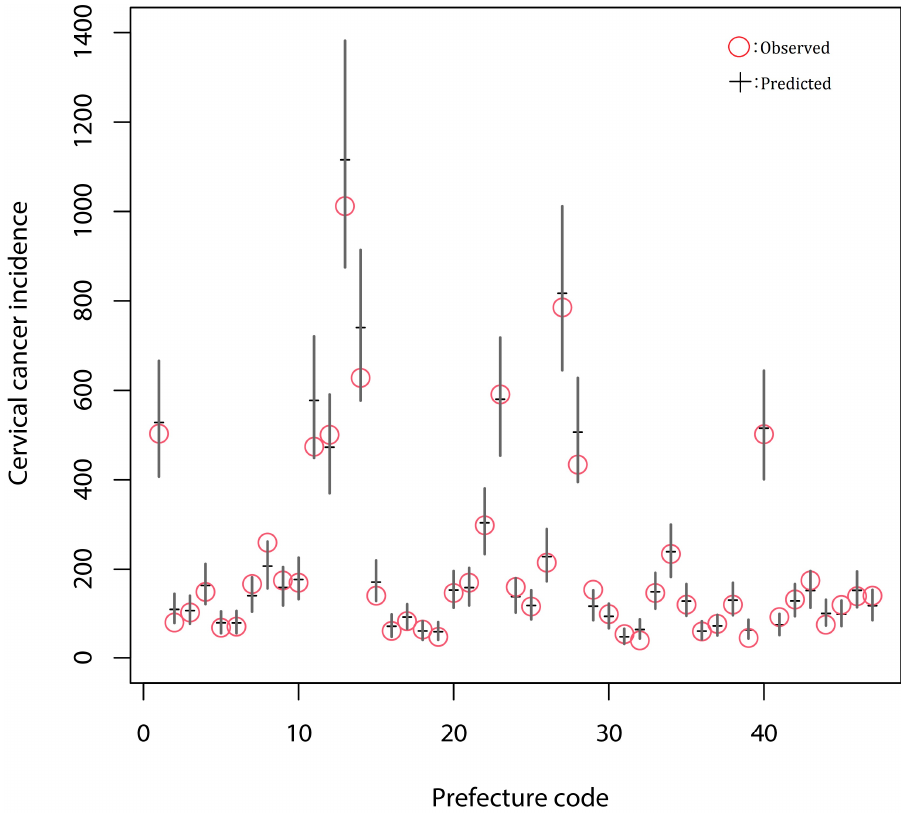
Figure 2. The predicted and observed incidences of cervical cancer in 2013 in 47 prefectures of Japan. The red circle denotes the observed CC incidence in each prefecture. The black horizontal bar and vertical solid line demonstrate the estimated CC incidence and its 95% confidence intervals. The relationships between observed and estimated prefectural CC incidences in other years are not shown here. Table 3. The explanatory variables and the estimates of regression coefficients in the model with the lowest AIC among the 1088 negative binomial regression models for cervical cancer incidence.